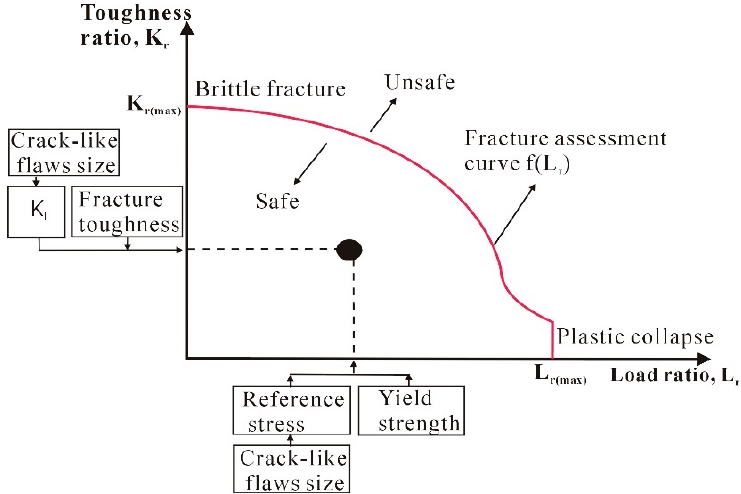
Figure 16. Failure-assessment diagram.